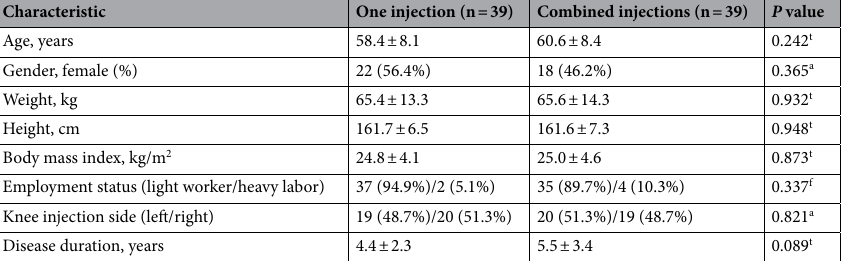
(Table 4). In the one-injection group, the Lequesne index scores improved significantly from baseline at 1-month postinjection, the maximal improvement was at 3 months, and the effects maintained significant from baseline